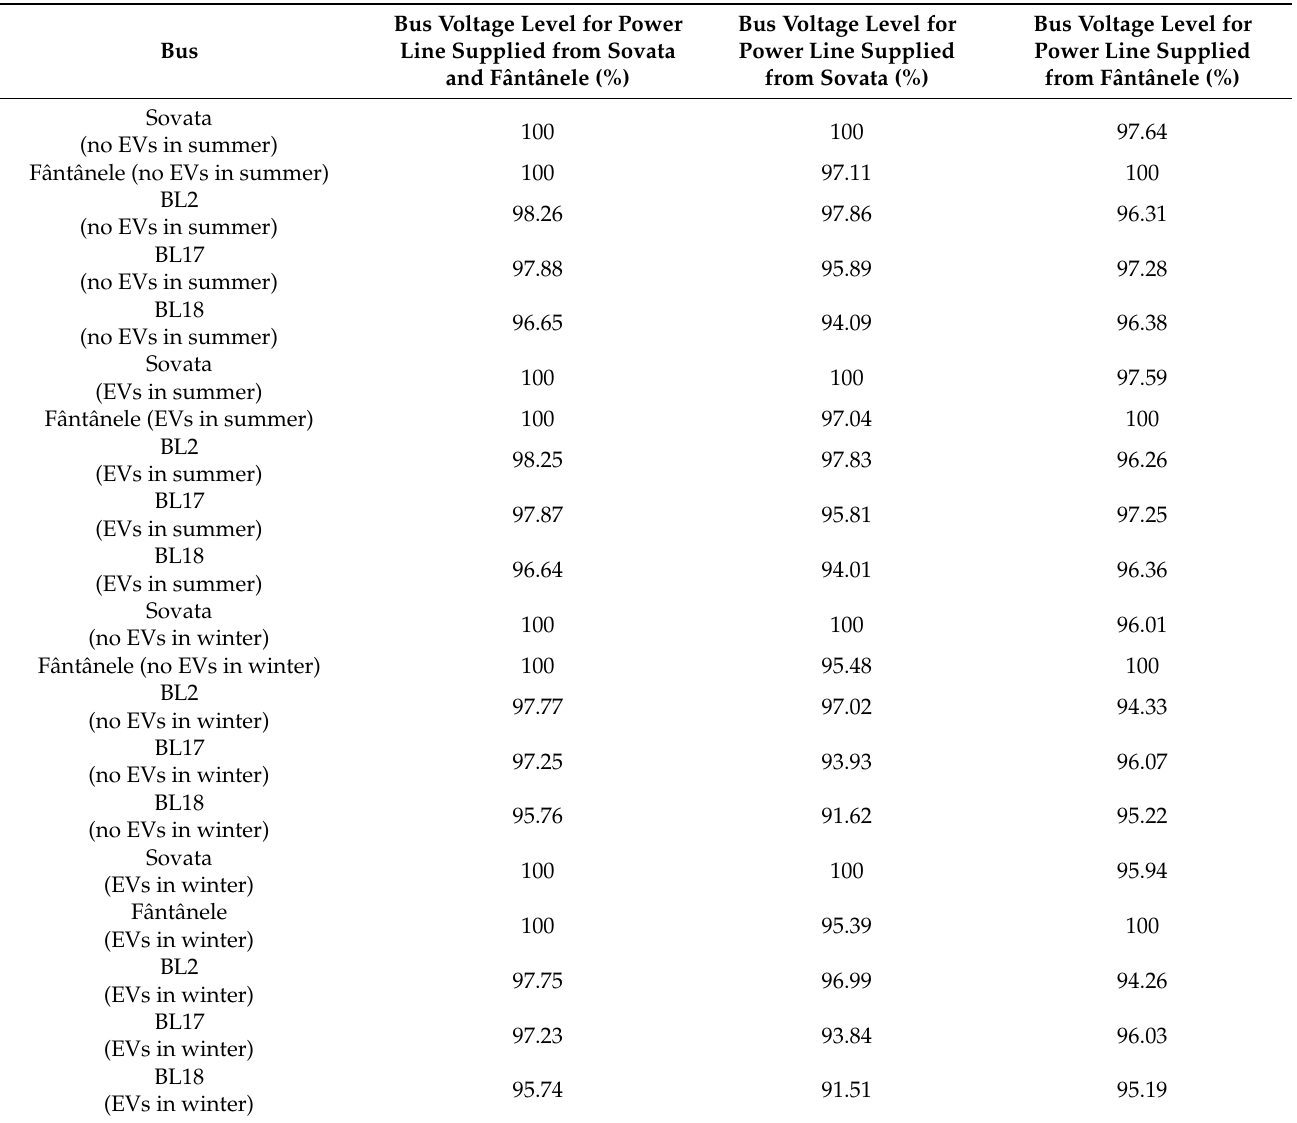
Table 31. Voltage level at 19:00 (scenario